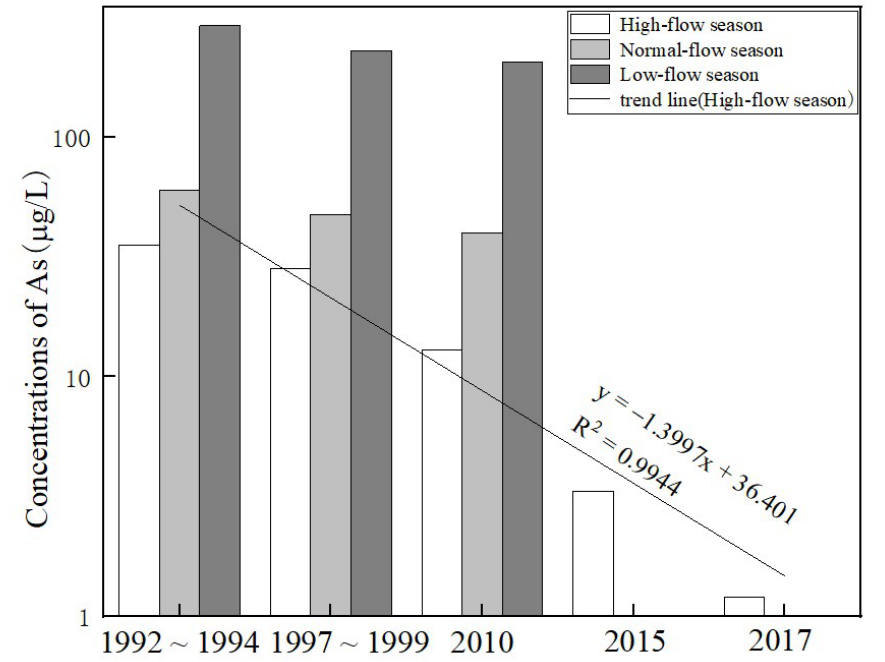
Figure 5. The seasonal variations in As in DLQ during the period from 1992 to 2017. Data were referred to [23,40,49,71].